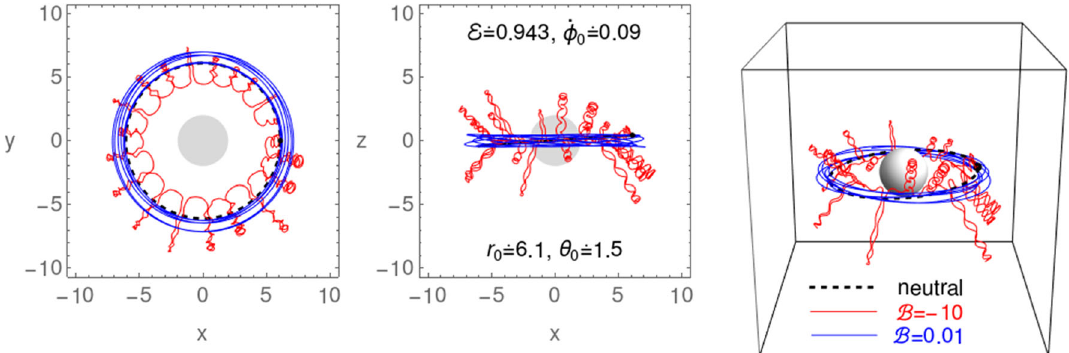
Fig. 11 ExampleofionizationmechanismforneutralparticlesinKep- lerian accretion disk. The LF and RR force acting on electrons and pro- tons (ions) are significantly different. In the presented case, the proton (blue) is oscillating around effective potential minima in the equatorial